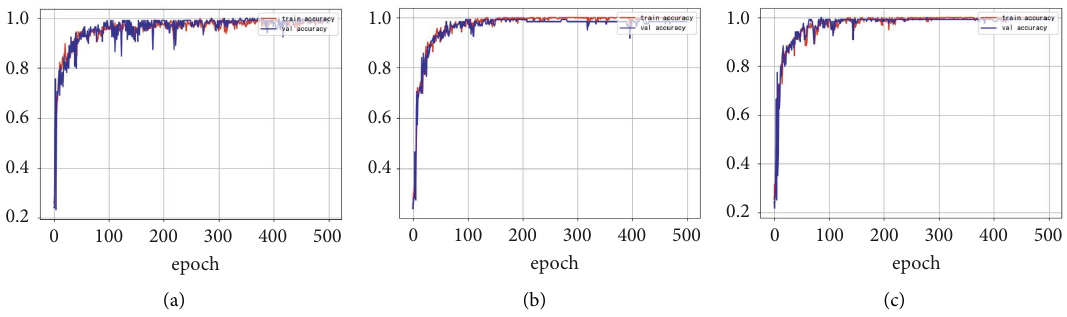
Figure 8: Accuracy curves of various network models. (a) 1DCNN network. (b) 1D-LSTM network. (c) 1DCNN-BiLSTM